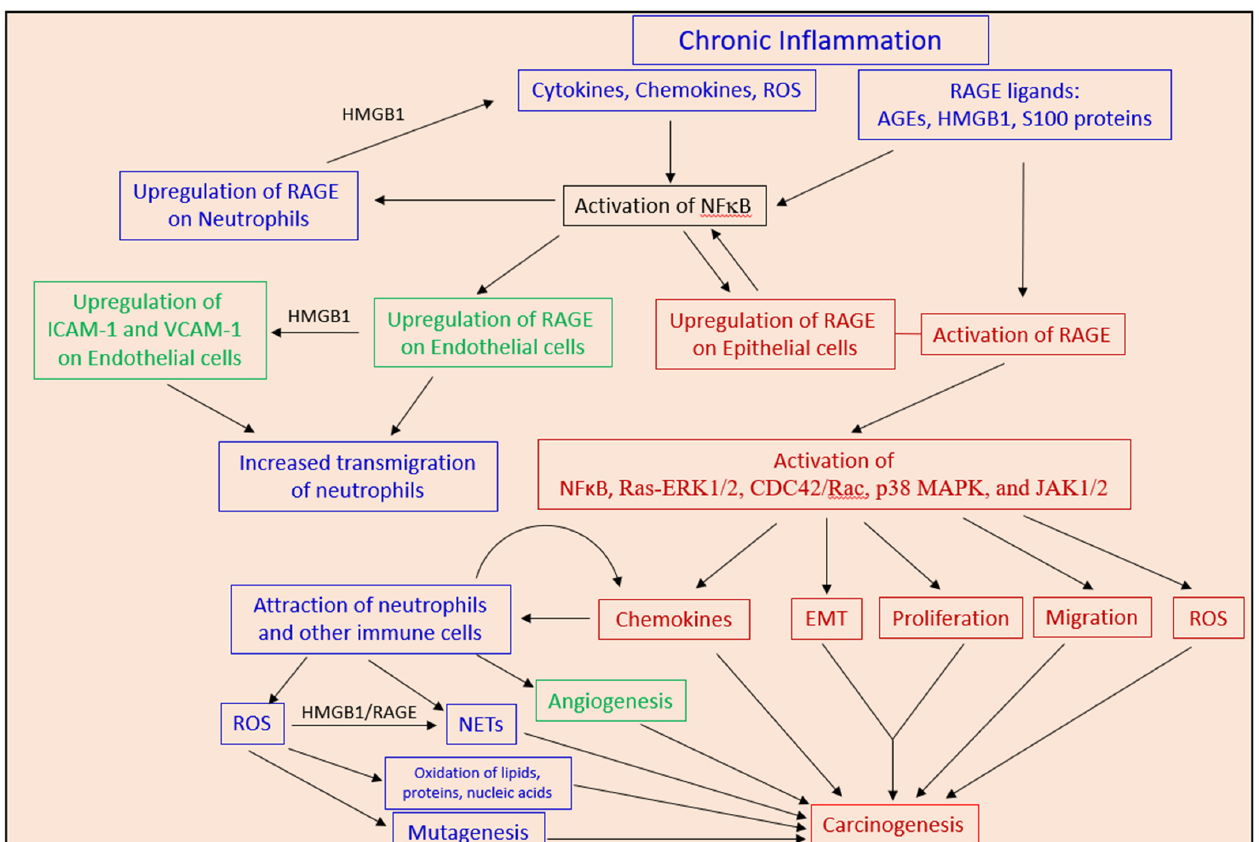
Figure 1. Chronic inflammation-induced carcinogenesis. The figure illustrates pathways in chronic neutrophilic inflammation-induced carcinogenesis that involves the activation of the RAGE signaling pathways in neutrophils (blue boxes), endothelial cells (green boxes) and epithelial cells (brown boxes). The different circuits and pathways are